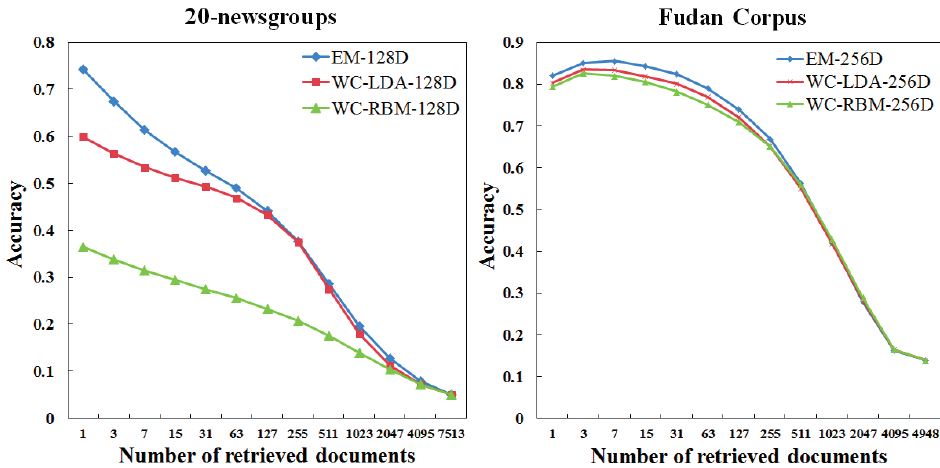
Figure 9. The document retrieving results of EM, WC-LDA and WC-RBM. Dimensionalities of 20-newsgroups and Fudan Corpus are reduced from 600D and 1000D to 128D and